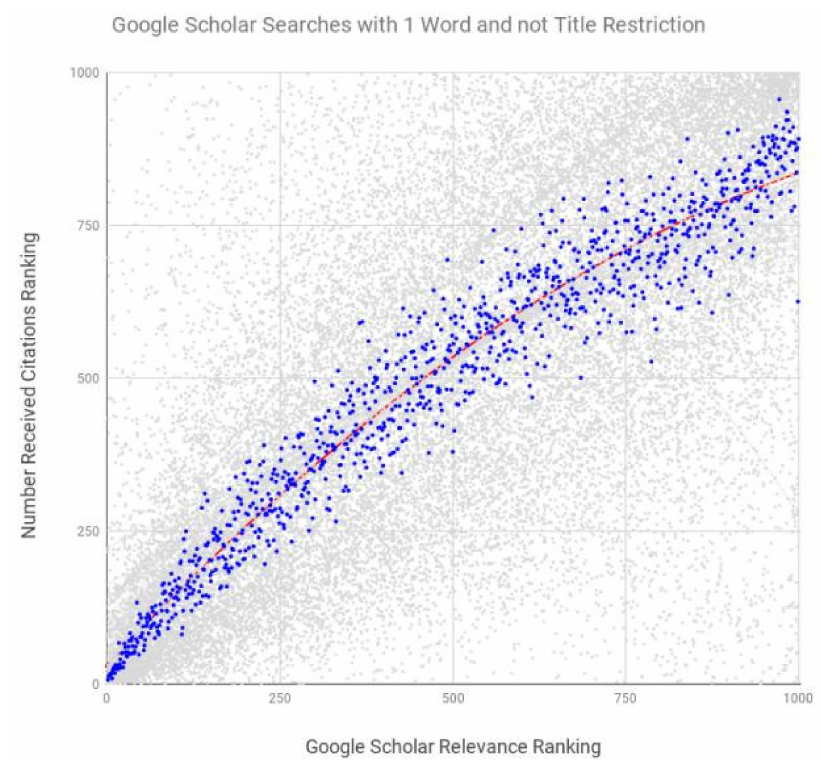
Figure 1. Google Scholar Searches with One Word and No Title Restriction (rho 0.968, median in blue, the rest of data in gray).